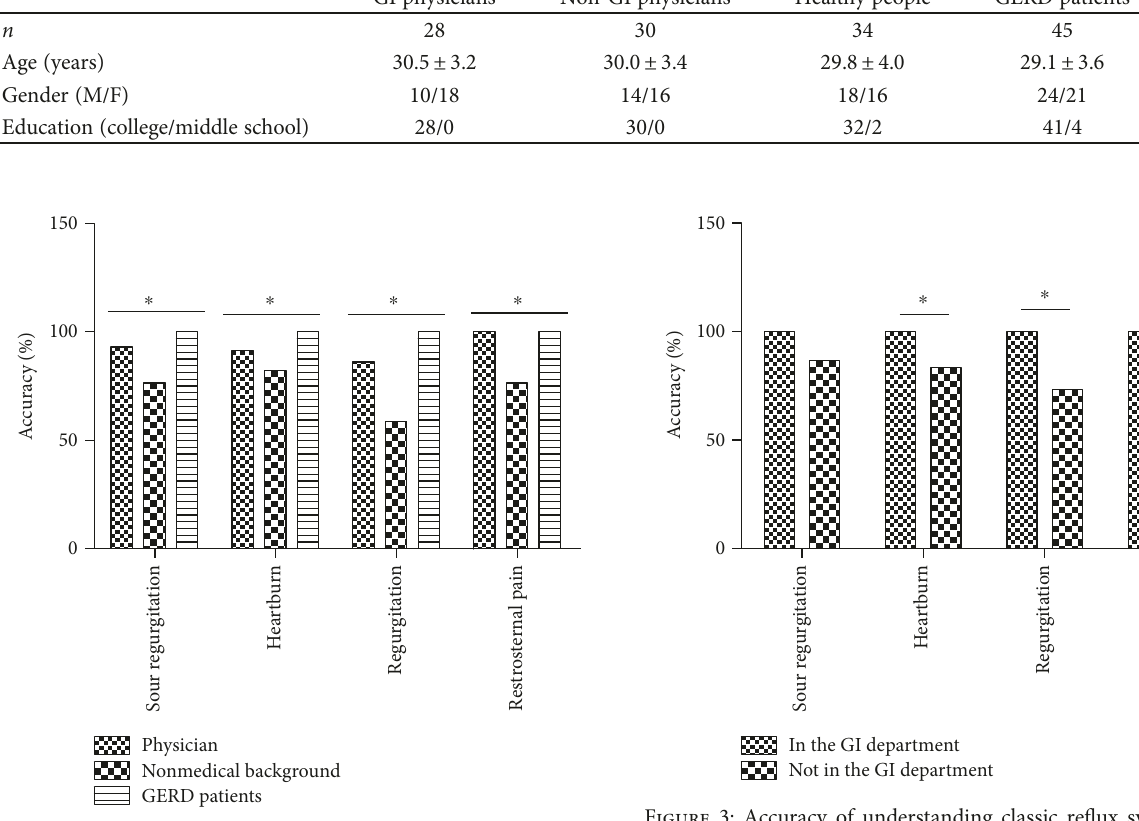
Figure 2: Di ff erence in the accuracy of the understanding the terms of re fl ux symptoms among the groups. ∗ P < 0 05 among the groups, chi-square test.